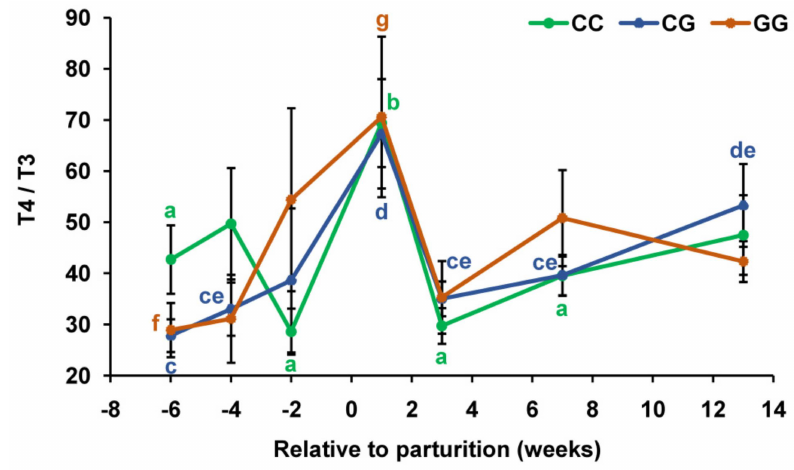
Figure 4. Total thyroxine to total triiodothyronine ratio (T4/T3) during the prepartum and postpartum periods in the serum of dairy cows with polymorphic variants of the DIO1 gene. Means with different letters differ significantly within each group (at least p < 0.05).